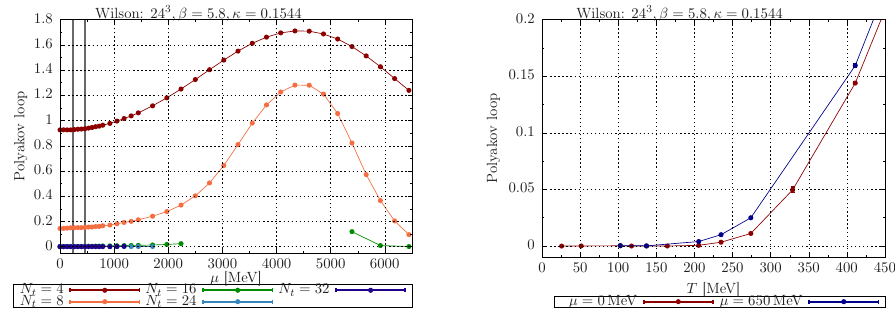
Figure 3: Polyakov loop as a function of the quark chemical potential (left) and temperature (right). The saturation density is reached at μ ∼ 4000